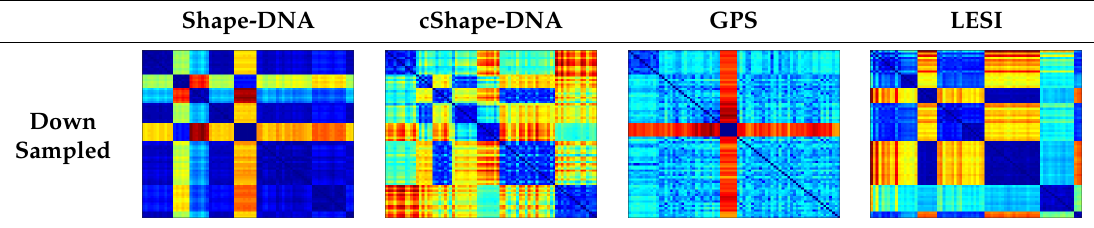
Figure 12. The Euclidean pairwise distance matrix of shape descriptors computed by (from left to right) Shape-DNA, cShape-DNA, GPS, and LESI algorithms from from down sampled TOSCA dataset by rate of